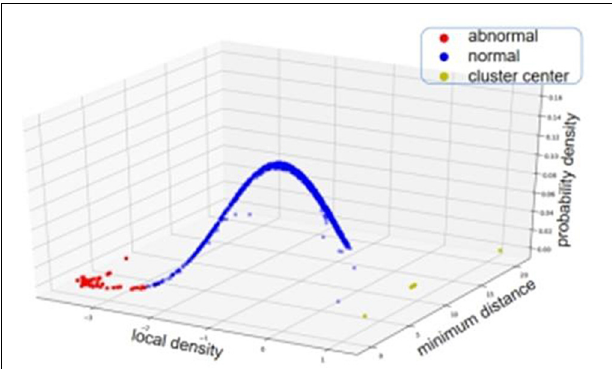
FIGURE 3 | An example of showing the two-dimensional Gaussian distribution of the statistic values (i.e., local density and minimum distance) based on simulation data. The blue points represent the segments with normal copy numbers while the red points represent the segments with abnormal copy